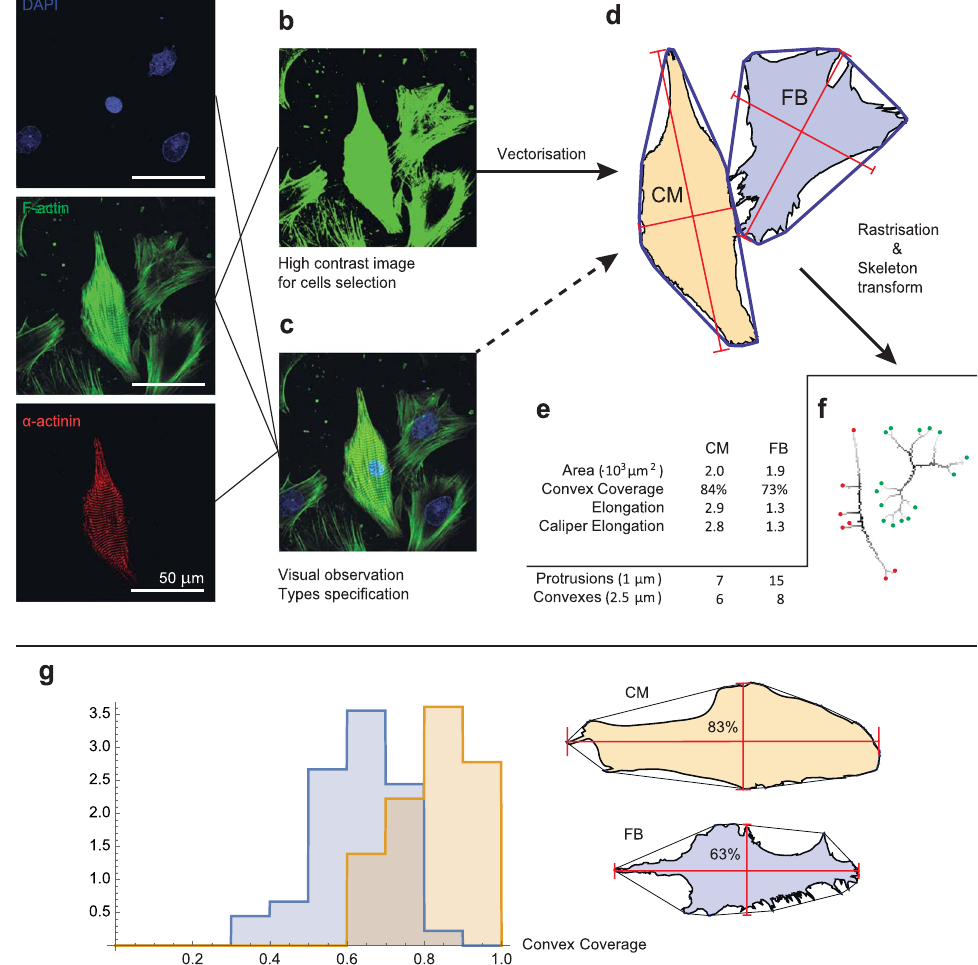
Figure 2. Algorithm for cell shape analysis in the experiments. Cardiac cells were observed experimentally with the use of immunohistochemical techniques. Panel (a) shows raw data on cells stained with DAPI (DNA, blue), phalloidin (F-actin, green) and monoclonal anti- α -actinin antibody ( α -actinin, red). Sub-figures ( b ) and ( c ) show the processed data used for cell contour selection and cell type classification. In ( b ), the contrast of F-actin staining was enhanced for cell contour selection. In ( c ), three channels were merged to obtain better cell representation for classification (cardiomyocyte vs. fibroblast). Sub-figure ( d ) shows the cell images obtained after segmentation. The convex hull is shown as a blue line around each cell. These images were used to obtain parameters such as area, convex hull coverage and elongations. Cell images were then rasterised with two resolutions (1 μ m and 2.5 μ m ), and skeleton transform was applied ( f ). The number of skeleton endpoints at a high resolution was considered as the number of protrusions. All the measured parameters are listed in ( e ). For details, see section III B. ( g ) Distribution of the convex coverage for two cell types. CM–cardiomyocyte (n = 36), FB–fibroblast (n = 45). The histogram shows that FBs cover a much smaller area within the convex hull than CMs. The cell shapes of the median samples in the experimental database are shown on the